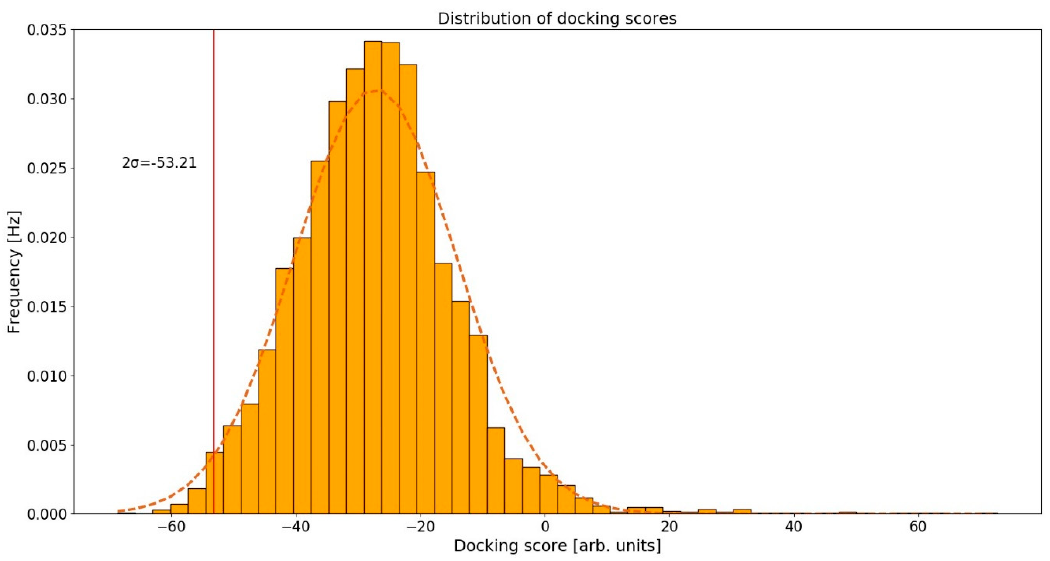
Figure 2. Normal distribution fitting of calculated docking scores.